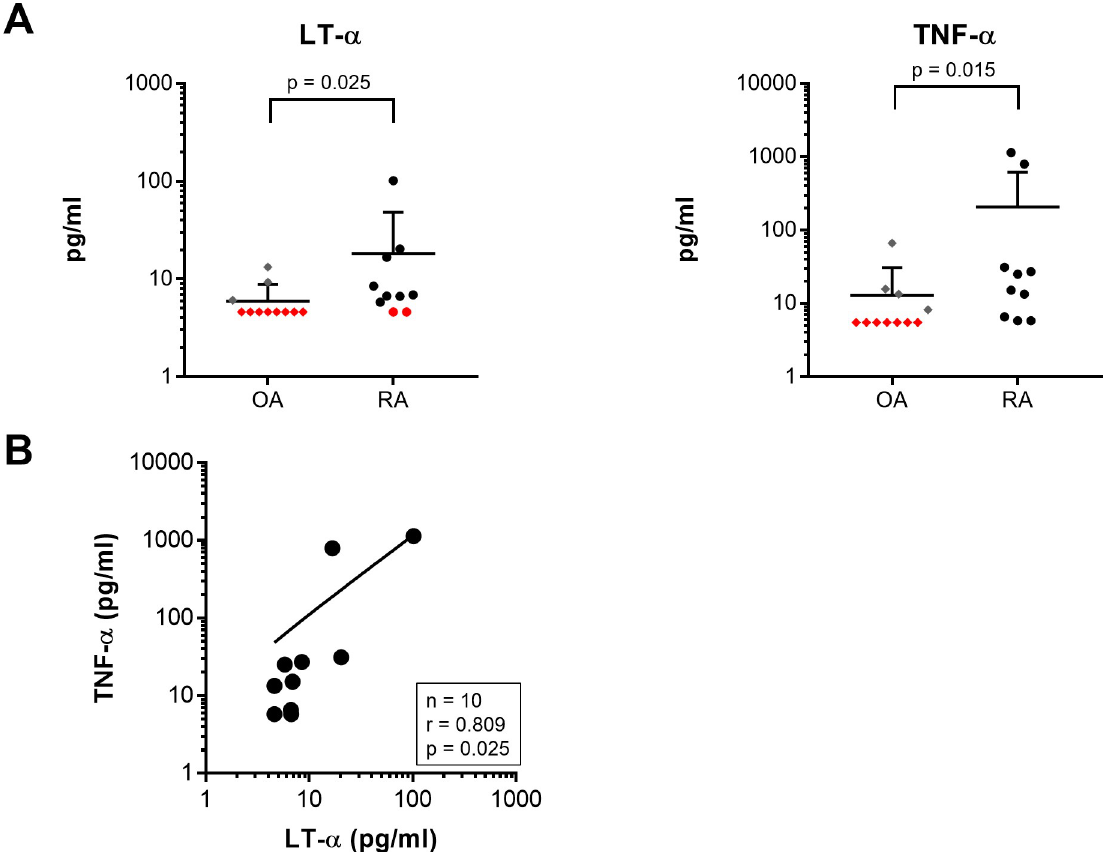
Fig 1. Concentrations of LT– α and TNF– α in synovial fluid. (A) Cytokine concentrations in synovial fluid collected from RA patients were higher than those in OA patients. Red points are values below the detection limit, and were taken as detection limit values. (B) A positive correlation was identified between LT– α and TNF– α concentrations in RA synovial fluid (n = 10, r = 0.809, p = 0.025). limit values. The concentration of LT- α in the synovial fluid from RA patients was 18.30 ± 28.40 (mean ± standard deviation) pg/ml, while that from OA patients was 5.96 ± 2.70 pg/ml (n = 10 in the RA group, n = 11 in the OA group). The concentration of TNF- α in syno- vial fluid from RA patients was 207.81 ± 390.88 pg/ml, while that from OA patients was 12.95 ± 217.32 pg/ml. The concentrations of LT- α and TNF- α were higher in RA synovial fluid than in OA synovial fluid. The concentration of LT- α was less than the detection limit in nine OA samples and two RA samples, and the concentrations of TNF- α was less than the detection limit in seven OA samples (Fig 1A). There was also a correlation between LT- α and TNF- α concentration in RA synovial fluid samples (n = 10, r = 0.809, p = 0.025) (Fig 1B).